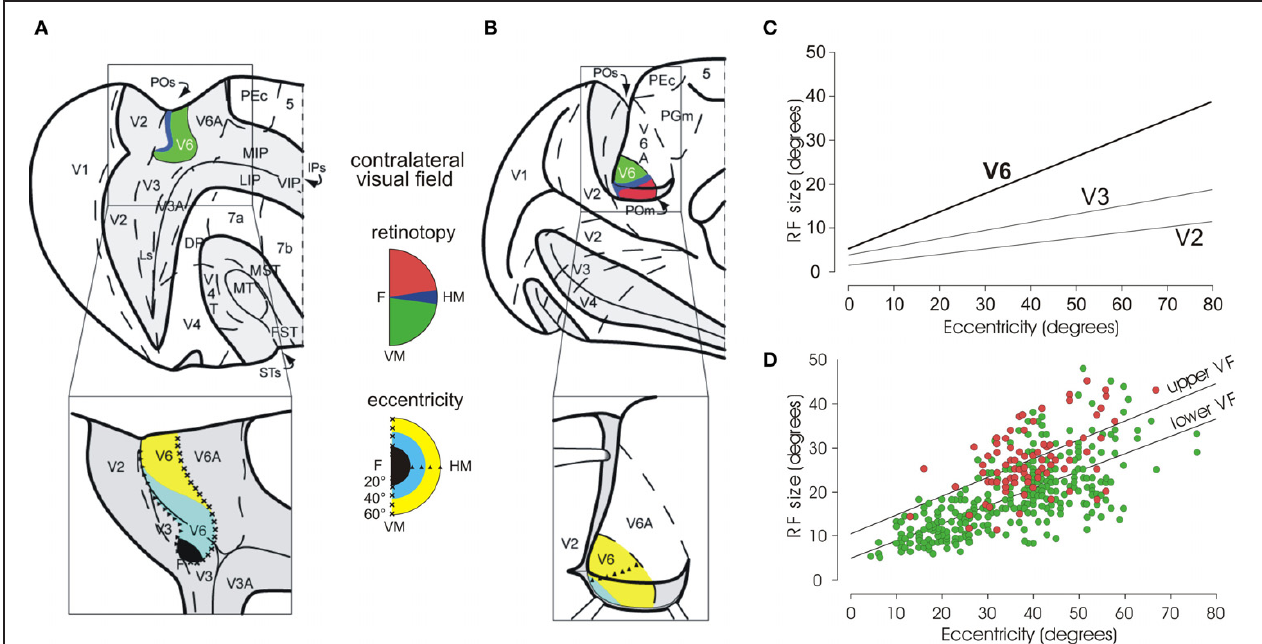
FIGURE 2 | Visual topography and receptive field properties of macaque area V6. (A) Dorsal view of caudal half of right hemisphere (and, below, enlargement of the parieto-occipital region) with the parieto-occipital (POs), lunate (Ls), and intraparietal (IPs) sulci shown opened to reveal the cortex buried within them (dark gray area). (B) Medial view of the caudal half of a the left hemisphere (and, below, enlargement of the parieto-occipital region), with the medial parieto-occipital sulcus (POs) opened. Area V6 is shown in color, according to the part of visual field it represents (conventions reported between A and B ). Note that V6 represents point-to-point the entire contralateral visual field, with an emphasis in the representation of the peripheral visual field. Triangles and crosses indicate the representation of the horizontal (HM) and vertical (VM)